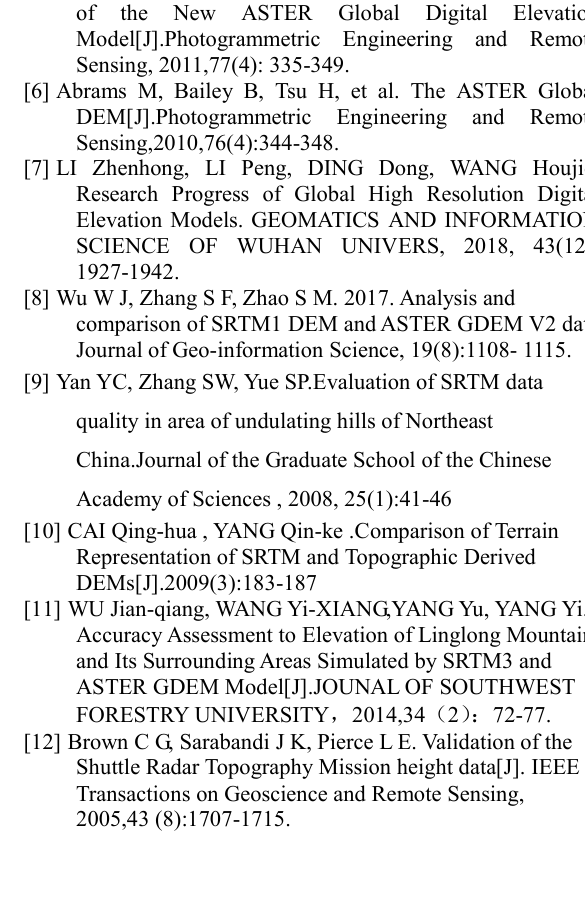
Table 3 ASTER GDEM, SRTM3 DEM and WorldDEM data elevation difference statistics in test area A